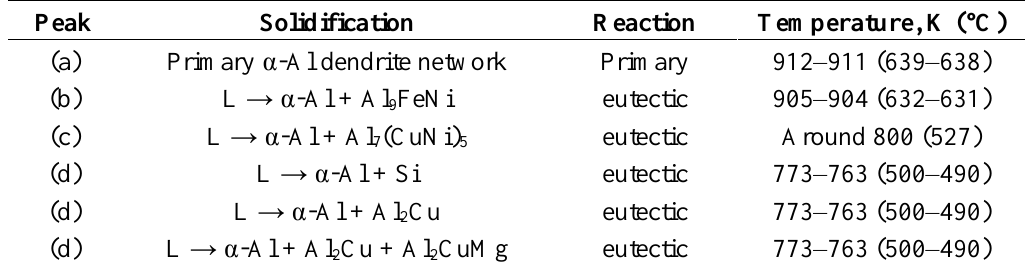
Table 3. Solidification sequence of Sample FC.